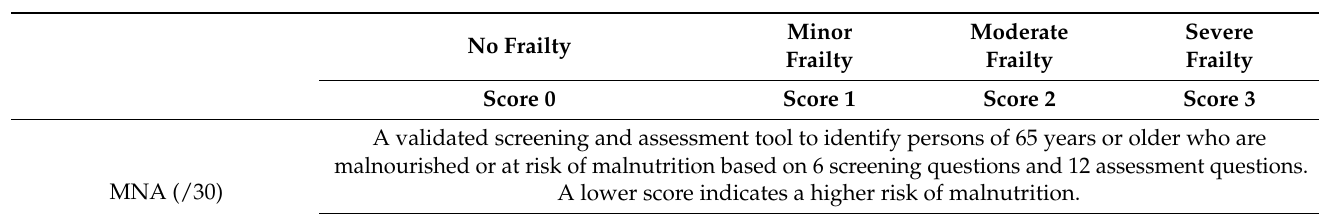
Table A2. Vigorito et al.’s frailty assessment